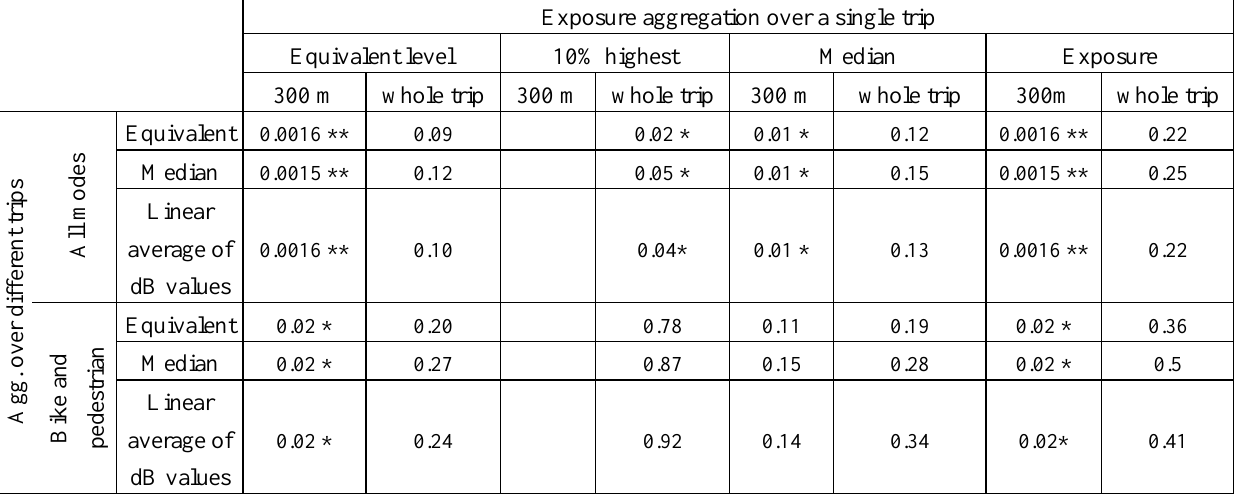
on the most exposed façade and the day is 1.7 × 10 −7 day,facade